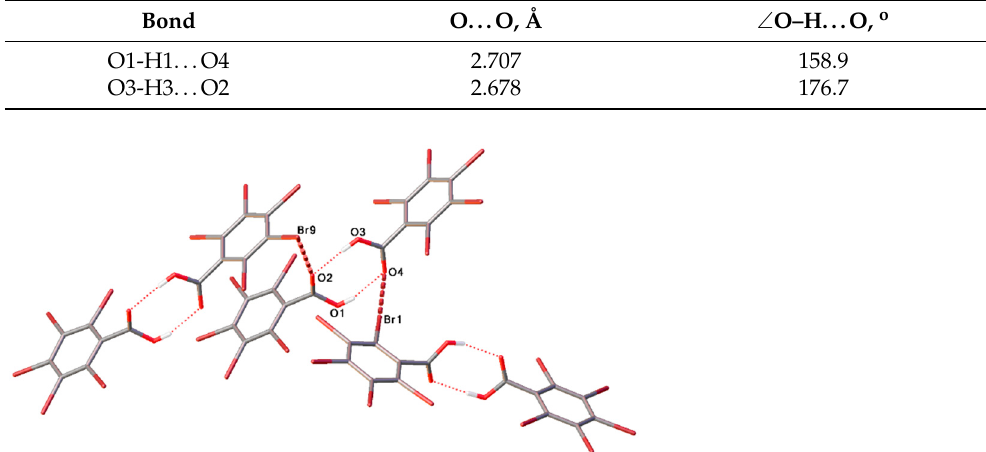
Figure 3. Crystal packing of 1 . Hydrogen O-H…O bonds are illustrated with dotted lines and Br…O contacts are illustrated with dashed lines.